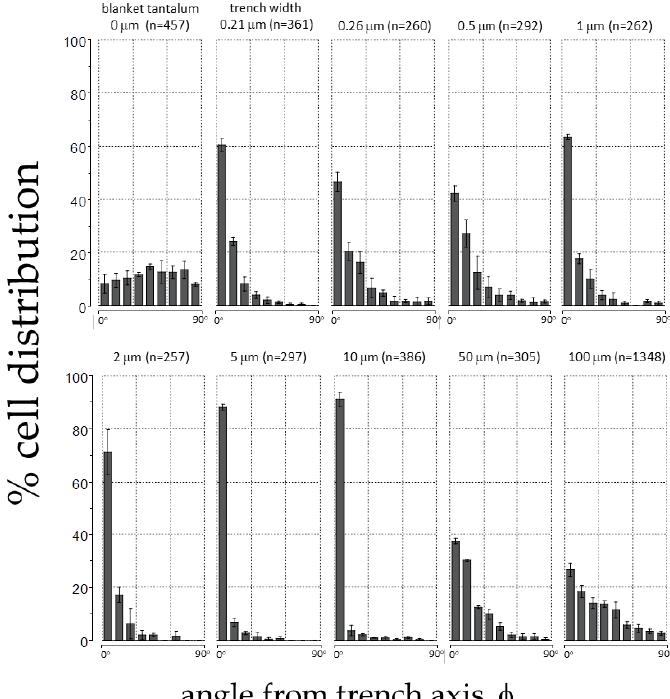
Figure 6. Distribution of adherent cell orientation (in percentage) on blanket tantalum film and comb structures with trench widths between 0.21 μm and 100 μm. The cell orientation is characterized as the angle ( φ ) between the nuclei long axis and the patterned trench axes. The number of adherent cells characterized (n) in each area is also presented in the plots. Each bin represents the percentage of cell population in a ±10° interval deviated from the trench axis. Results show that cells aligned preferentially with the trench axes.